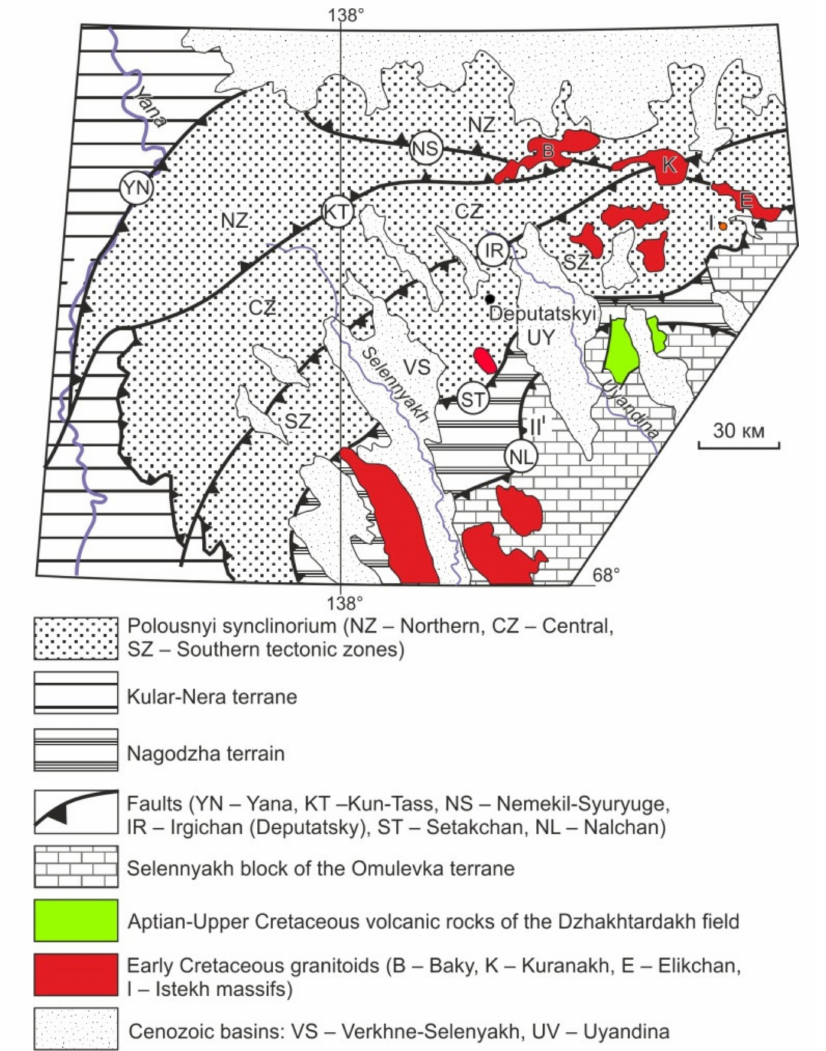
Figure 2. Tectonic sketch map of the Polousnyi synclinorium, modified from [59]. For location see Figure